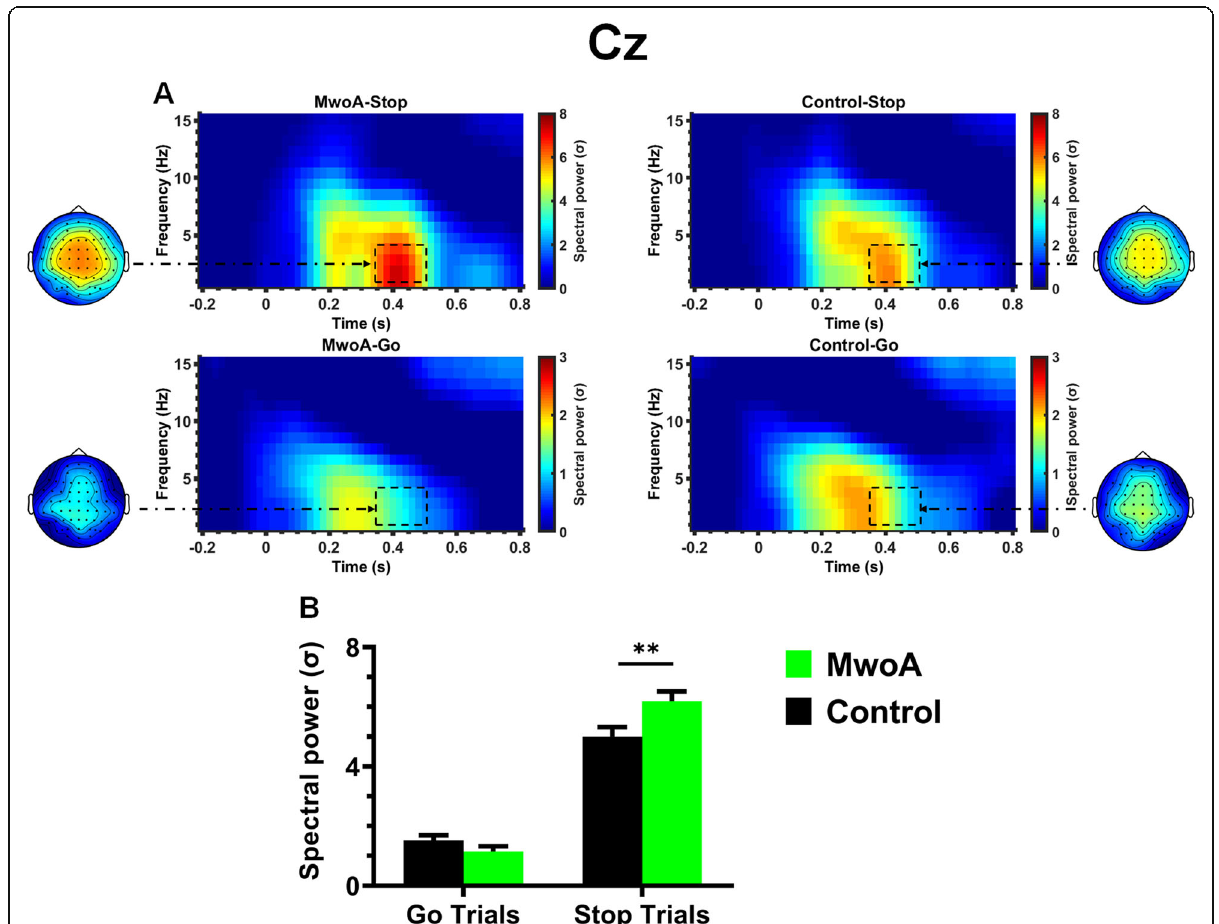
Fig. 3 Time-frequency results. a Time-frequency plots showing delta changes in normalized power in go and stop trials (left) for patients with MwoA and healthy controls for the selected electrode (Cz). Black dotted squares indicate the time-frequency region in which theta power in stop trials was significantly higher in patients with MwoA than in healthy controls. Scalp topography maps show the spatial distribution of theta power (4 – 8 Hz) in go and stop trials between 350 and 500 ms. The color scale indicates spectral power in SD. b Means and standard errors (SEs) of the delta power (4 – 8 Hz) between 350 and 500 ms at Cz in the two groups. **, p <